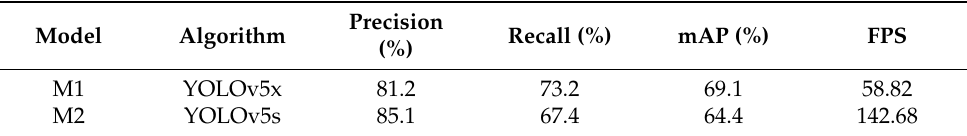
Table 1. YOLOv5 models results on small and medium-sized construction tools [9]. (Reproduced with permission from Lee et al., KSCE Journal of Civil Engineering; published by Korean Society of Civil Engineers, 2023).